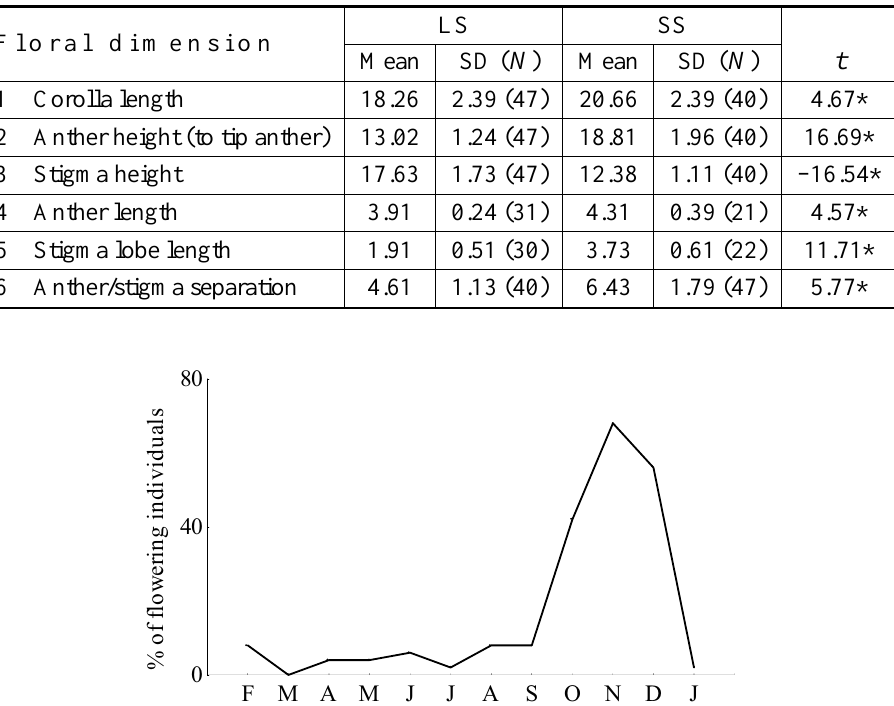
Floral dimensions (mm; measurements taken as indicated in Fig. 1) and results of t -test for long-styled (LS) and short-styled (SS) morphs of Palicourea crocea in the Upper Paraná River floodplain. SD: standard deviation. *P < 0 . 01 .